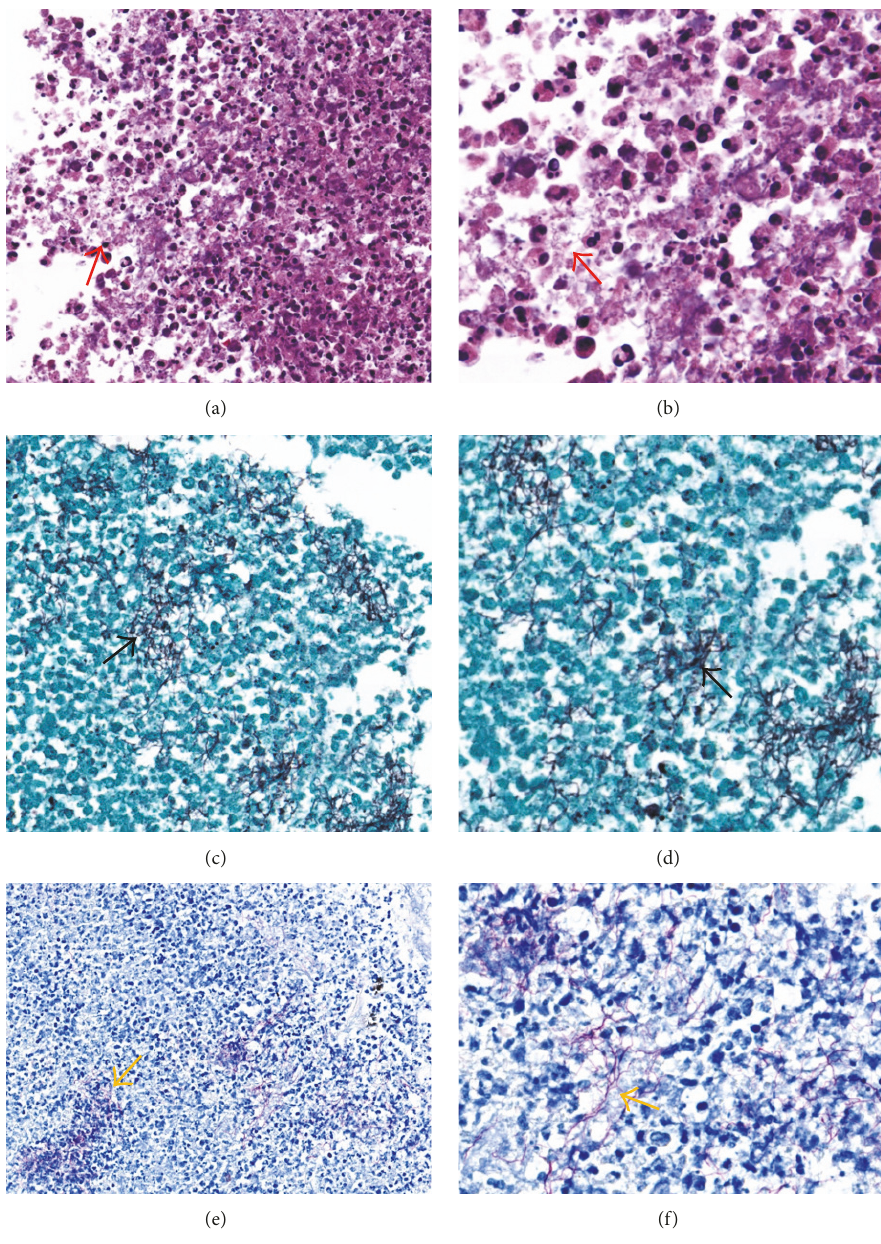
Figure 3: Renal mass pathology shows multiple renal abscesses with filamentous structures (red arrow) on hematoxylin and eosin stain under (a) low power (40x) and (b) high power (100x). Gomori’s methenamine silver stain shows no fungal hyphae but highlights the filamentous bacterial forms (black arrow) under (c) low power (40x) and (d) high power (100x). These filamentous bacteria stain weakly positive with Fite’s stain supporting the diagnosis of Nocardia species (yellow arrow) under low power (40x) (e) and high power (100x)